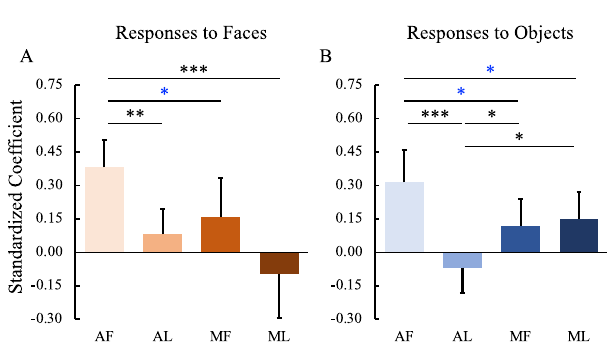
Fig. 9 | Functional relationships between the amygdala and the temporal face patches. Standardizedbeta-coef fi cientsforlinearregressionwithresponsestofaces ( A ) and objects ( B ) in the amygdala as outcome and responses to faces/objects in eachofthetemporalfacepatchesaspredictors(thenameisshownasthehorizontal axis labels at the bottom of each column). P values were calculated with bootstrap tests ( n =10,000) adjusted for multiple testing using the Holm-Bonferroni method. Black* p <0.05,** p <0.01,*** p <0.001.Blue* p <0.05uncorrected.Boxplotsdisplay meanvalues±95%CI.MFmiddlefundalfacepatch,MLmiddlelateralfacepatch,AF anterior fundal face patch, AL anterior lateral face